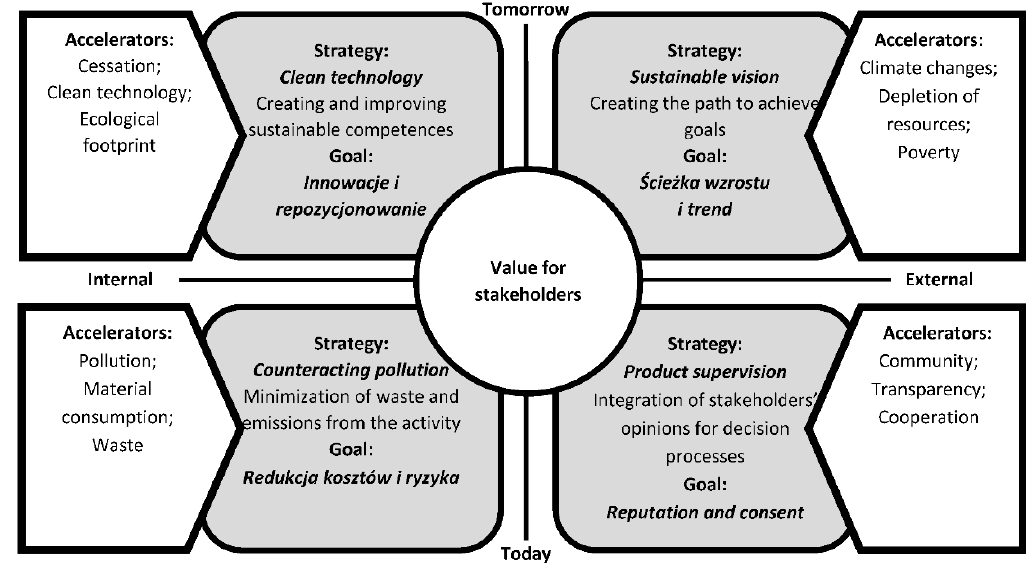
Figure 5. Sustainable Value Framework. Source: Hart S. L., Milstein M. B., Creating sustainable value, Academy of Management Executive , Vol. 17, No. 2, 2003, pp. 60.